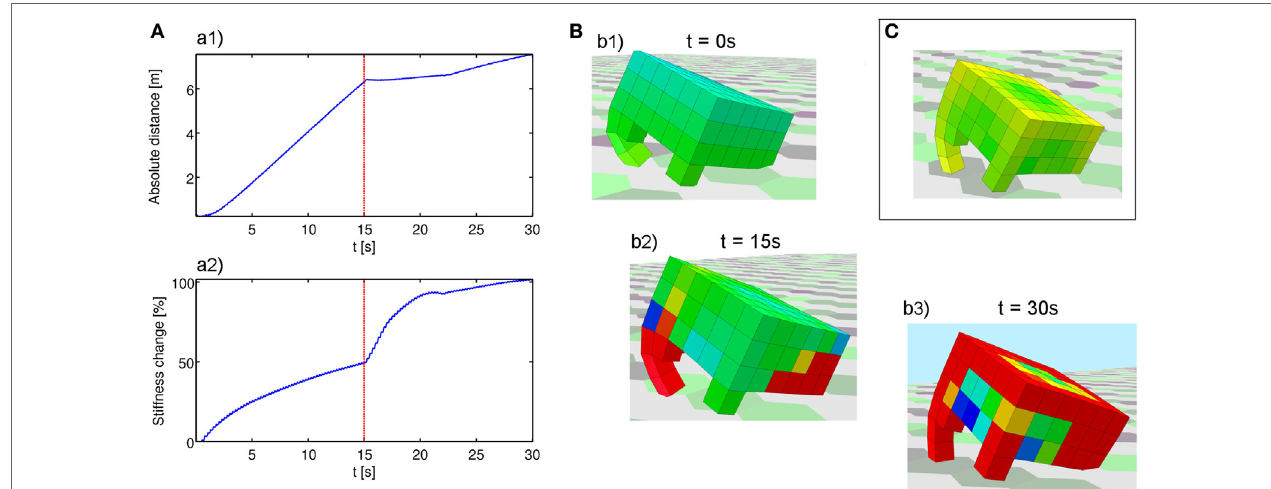
FiGUre 2 | An example of how environment-mediated morphological developmental plasticity can entail increased adaptivity and robustness in dynamic environments. Although demonstrated in a locomotion task, this ability is a constituent element of plant intelligent and adaptive behavior, and it is easy to foresee an application of these concepts to a more plant-inspired domain. (A) (a1) Distance traveled by the robot over time. (a2) Entity of the developmental adaptation (% stiffness change). (B) A successful robots at three different points in time during its life. Colors represent material stiffness (warmer → stiffer), which is under both evolutionary and developmental control. (b1) The robot at its birth ( t = 0 s), with its evolved stiffness distribution. (b2) Final form after experiencing a gravity of g =− 9.81 m / s 2 for 15 s. Similarly to what happens in biology, parts of the body that are subject to repeated mechanical stimulation tend to strengthen. Note that the small lateral legs do not touch the ground under the first gravity level. To the best of our knowledge, this is the first example of an artificially evolved Wolff’s law for simulated soft-bodied creatures. (b3) Final form after experiencing a new gravity level of 2 g , to which the robot was never exposed during optimization. After a sudden drop in the locomotion performance (see plot (a1), immediately after t = 15 s ), a new developmental adaptation (a2) allows the robot to start locomoting again even in the new, previously unseen situation, retaining almost 40% of its original speed. In addition to further stiffening the limbs that are subject to impacts with the ground (note how the shorter lateral limbs touch the ground under the increased gravity level), a stiff “skeletal” structure/frame emerges when gravity is increased, allowing to better sustain and distribute the increased mechanical load. (c) The distribution of the adaptation rates responsible for the developmental change (warmer colors denote higher stiffening in response to mechanical stimulation). See the robot in action here: https://youtu.be/oIO2y--mCXE. A close-up of the sensory stimulation driving the adaptive change can be seen here: